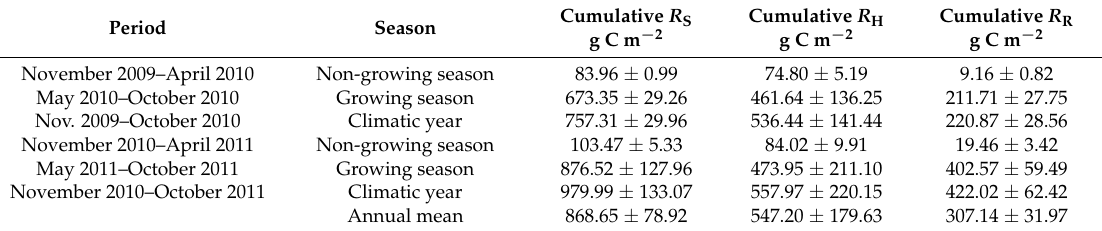
Table 3. Cumulative soil surface CO 2 fluxes ( ± standard deviation (SD)) in the control plot ( R S ), in the trenched plot ( R H ), and rhizospheric respiration ( R R ). The means ± SD of the three plots are